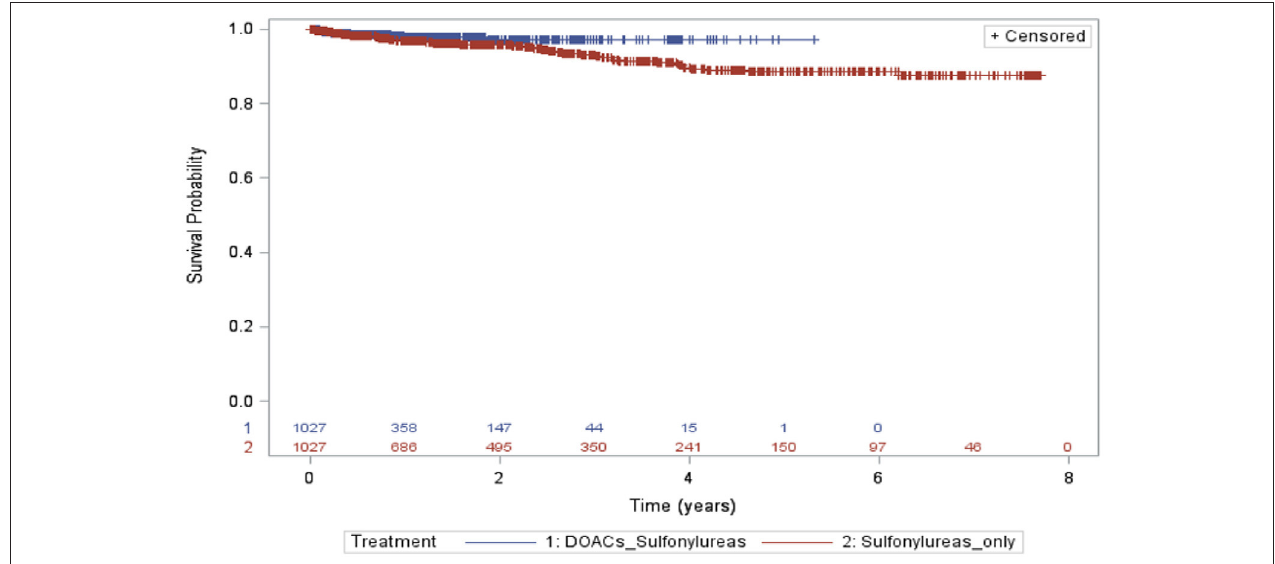
FIGURE 3 | Kaplan–Meier curves for the incidence of hypoglycemia during the follow-up period (sulfonylureas and DOACs vs. sulfonylureas